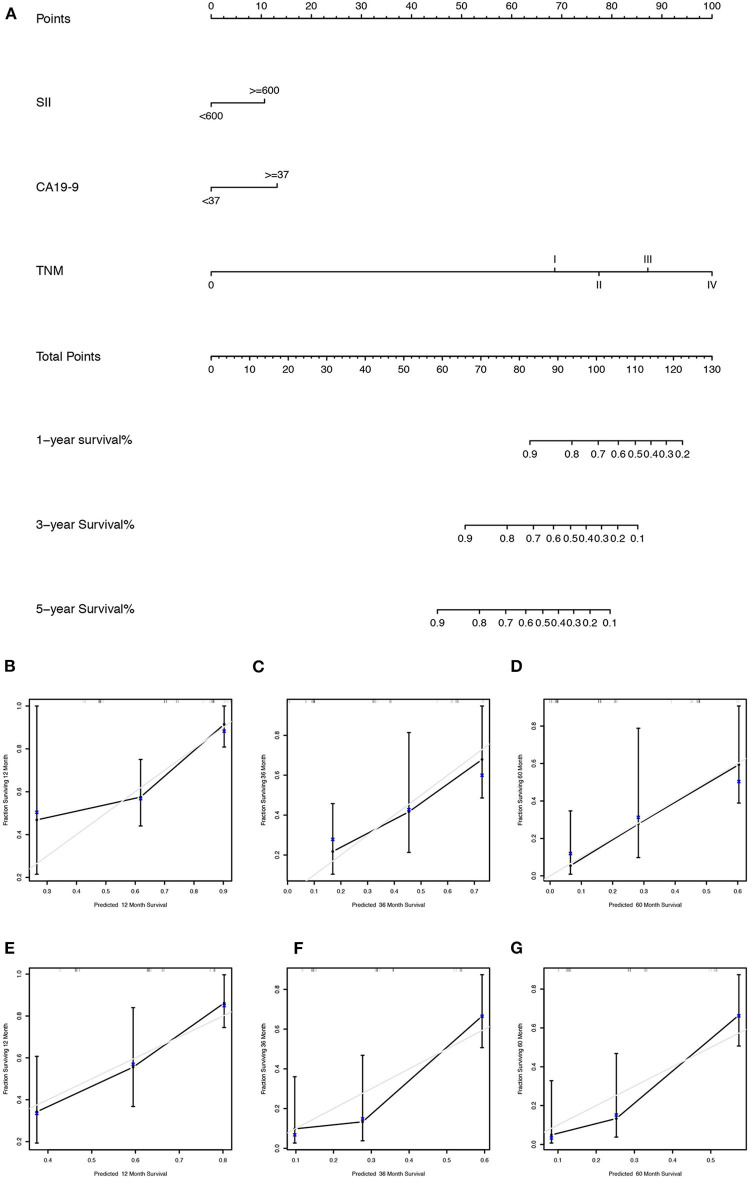
(A) The nomogram for predicting 1-, 3-, and 5-year survival probabilities of GBC patients based on SII levels, CA 19-9 levels, and AJCC stage; calibration curves of the nomogram for predicting survival probabilities of 1 (B), 3 (C), and 5 years (D) in the training cohort and 1 (E), 3 (F), and 5 years (G) in the validation cohort. The x axis plotted nomogram-predicted probabilities, whereas the y axis plotted observed probabilities of OS. The gray diagonal line indicated the ideal calibrated model.